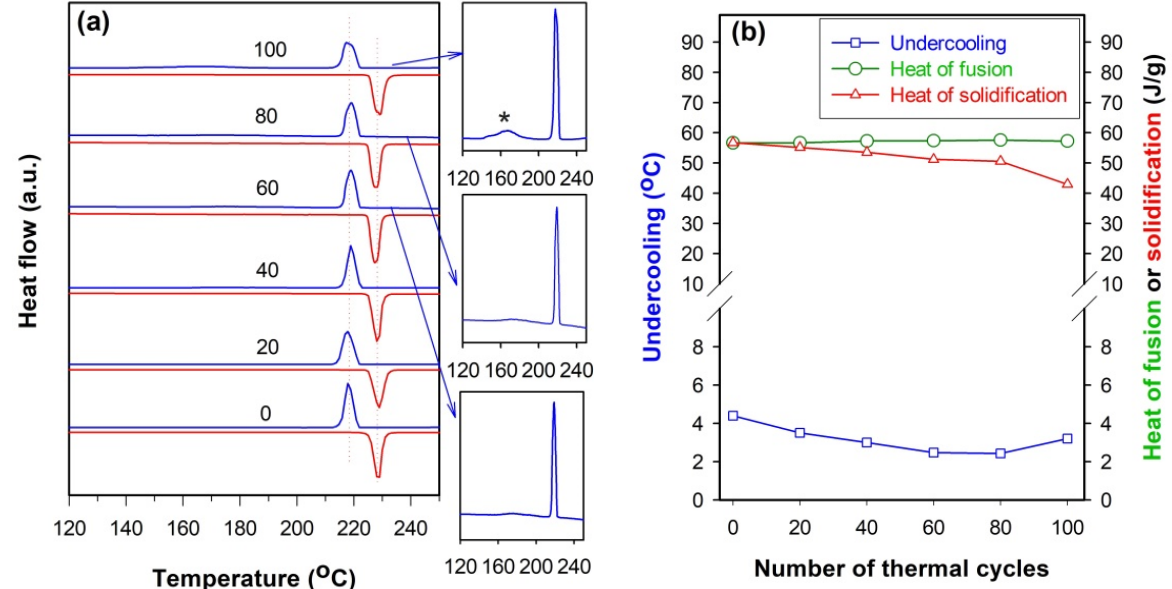
Figure 9. ( a ) DSC curves of SnZn 0.04 Cu 0.02 @SiO 2 microspheres (encapsulation times = 3) after different numbers of thermal cycles and ( b ) plot of both the undercooling and latent heat vs. the number of thermal cycles.